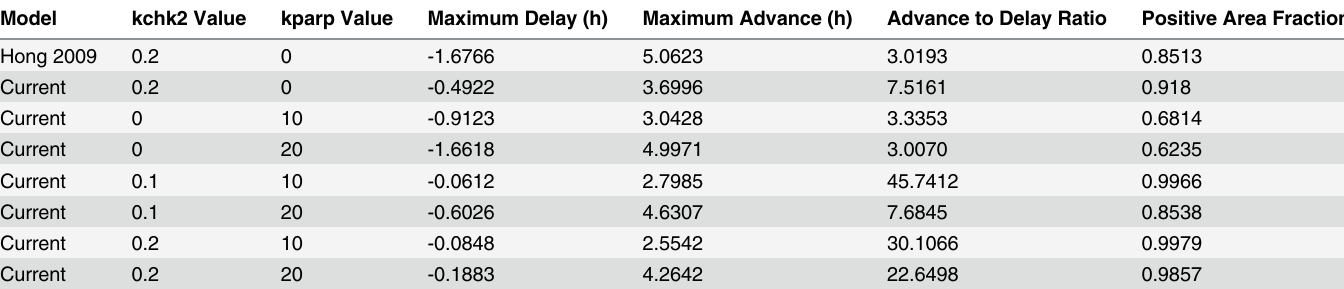
Table 4. Results for the analysis of phase shifting behavior by variables kchk2 and